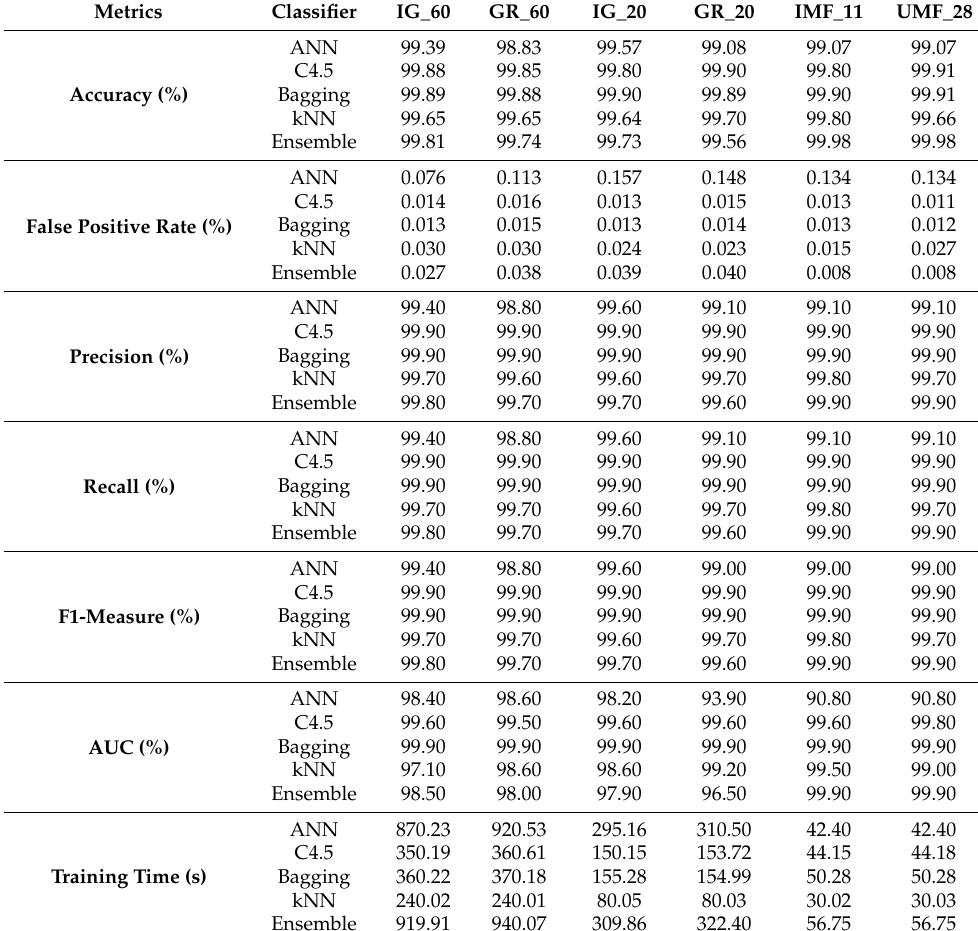
Table 4. Performance evaluation results for the different feature selection approaches concerning five ML models by using